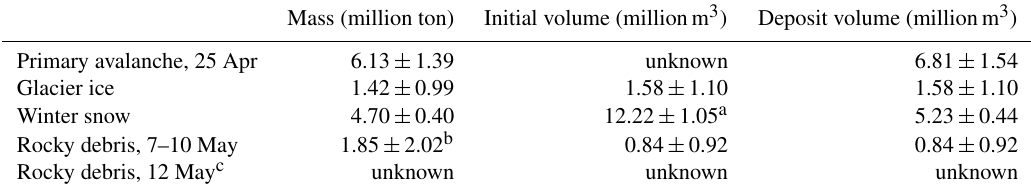
Table 4. Summary of mass and volume of avalanches.